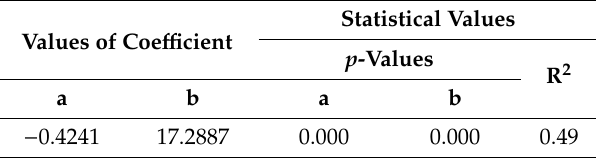
Table 5. Parameters of the equation [Lac = a * T 20 + b] expressing the influence of temperature on linolenic acid content in the seeds of winter oilseed rape. Statistical Values Values of Coe ffi cient